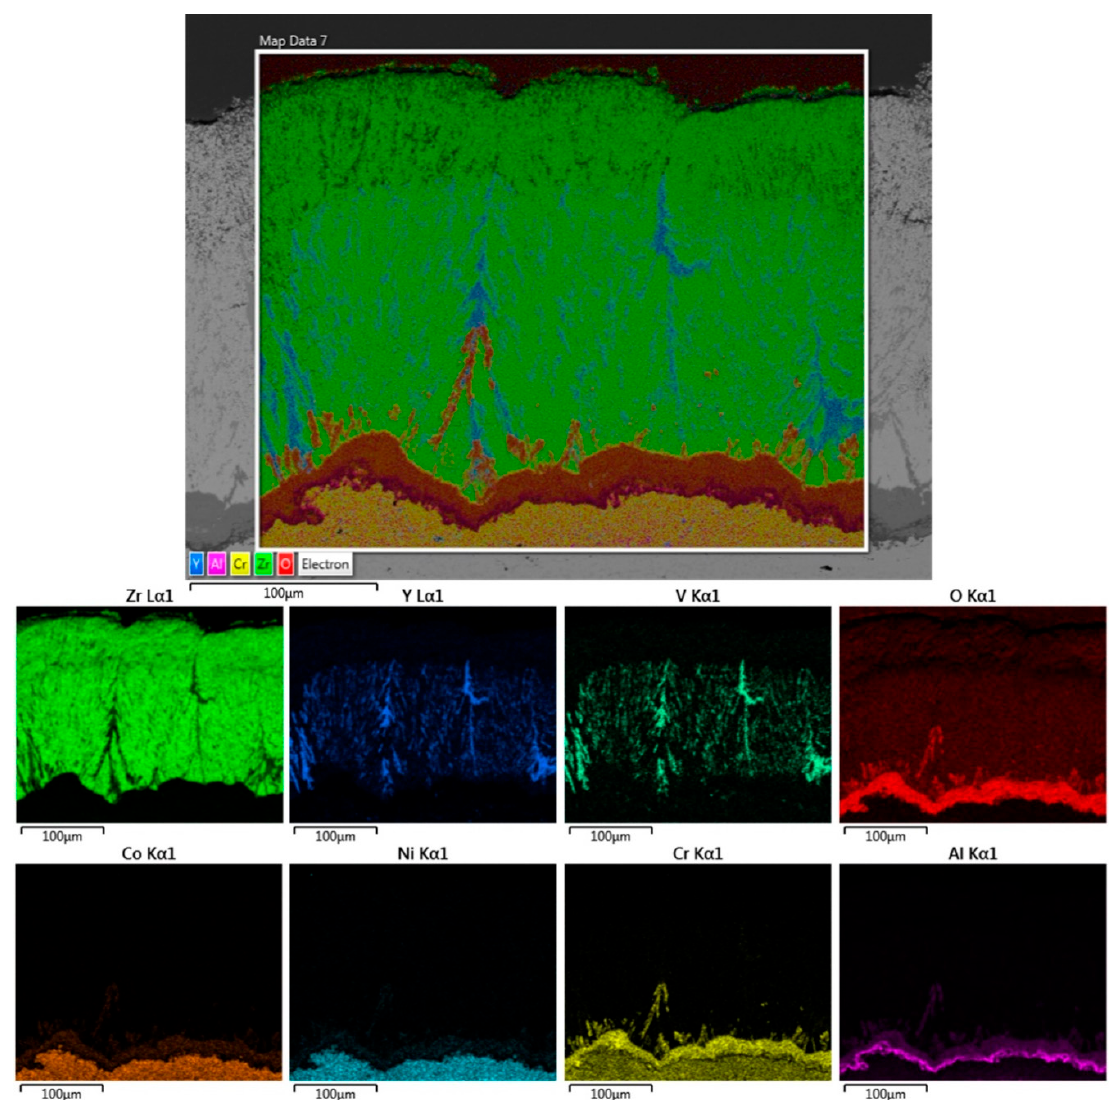
Figure 6. Cross-sectional microstructure with elemental mapping analysis belonging to TBC system after the hot corrosion test.